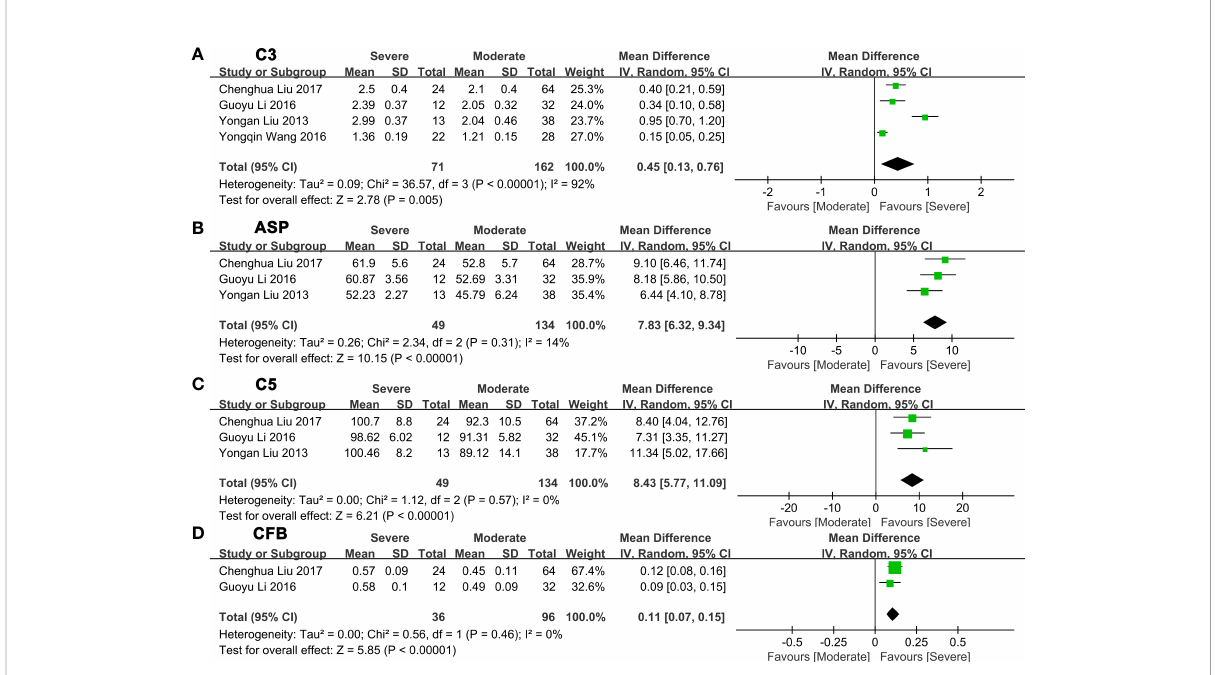
FIGURE 4 Forest plots of the deviation of complement components between moderate and severe NAFLD. (A) A random effect model was used to analyze the deviation of C3 between moderate NAFLD and severe NAFLD. (B) A random effect model was used to analyze the deviation of ASP between moderate NAFLD and severe NAFLD. (C) A random effect model was used to analyze the deviation of C5 between moderate NAFLD and severe NAFLD. (D) A random effect model was used to analyze the deviation of CFB between moderate NAFLD and severe